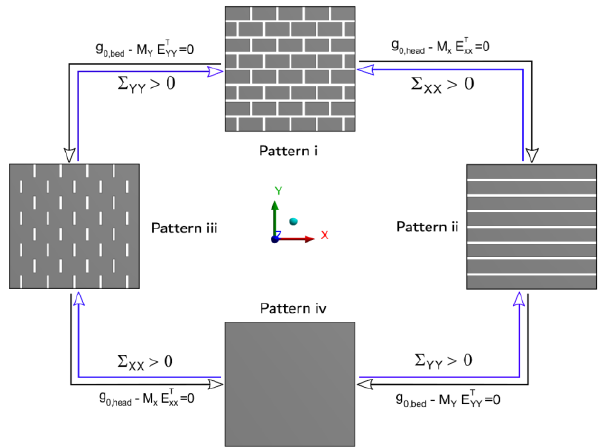
Figure 5. Possible joint patterns of mortarless refractory masonry structure and joint closure/reopening criteria.